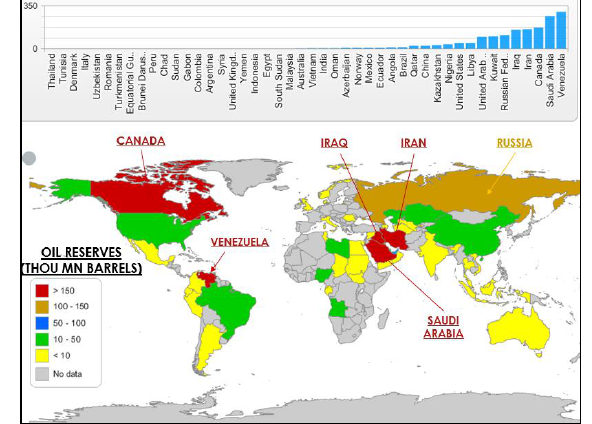
Figure 3. Statistics of proved oil reserves in 1996